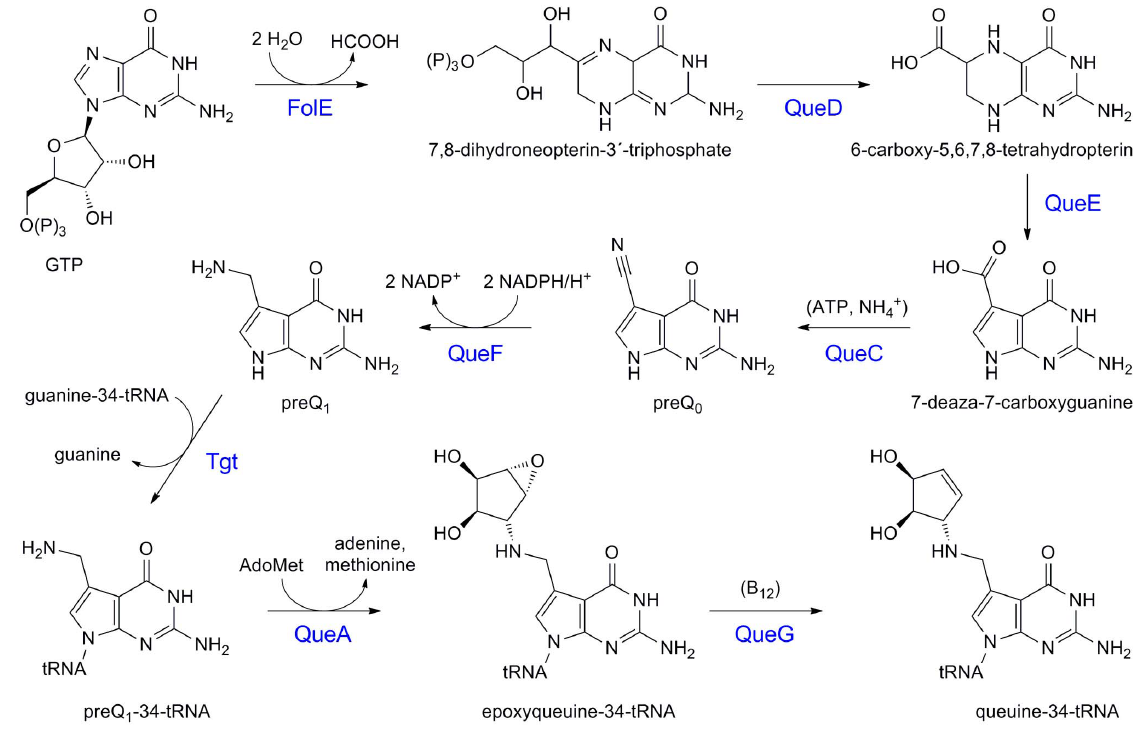
Figure 2. Biosynthesis of the modified tRNA base queuine. Substrates and cosubstrates: GTP, guanosine 5 9 -triphosphate; AdoMet, S - adenosylmethionine; B 12 , coenzyme B 12 ; preQ 0 , 7-cyano-7-deazaguanine; preQ 1 , 7-aminomethyl-7-deazaguanine; enzymes: FolE, GTP cyclohydrolase I; QueD, 6-carboxy-5,6,7,8-tetrahydropterin synthase; QueE, 7-carboxy-7-deazaguanine synthase; QueC, preQ 0 synthetase; QueF, preQ 0 reductase; Tgt, tRNA-guanine transglycosylase; QueA, S -adenosylmethionine:tRNA ribosyltransferase-isomerase; QueG, epoxyqueuosine reductase.